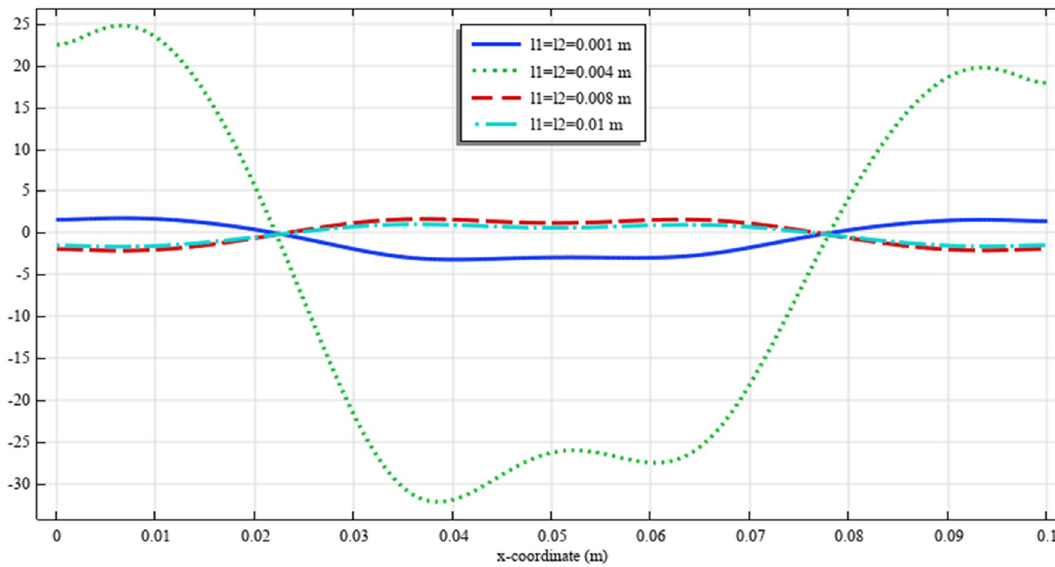
Figure 9. The displacement u y ( x , b / 2 )/ | u 0 | for different values of ℓ 1 and ℓ 2 (COMSOL Multiphysics).